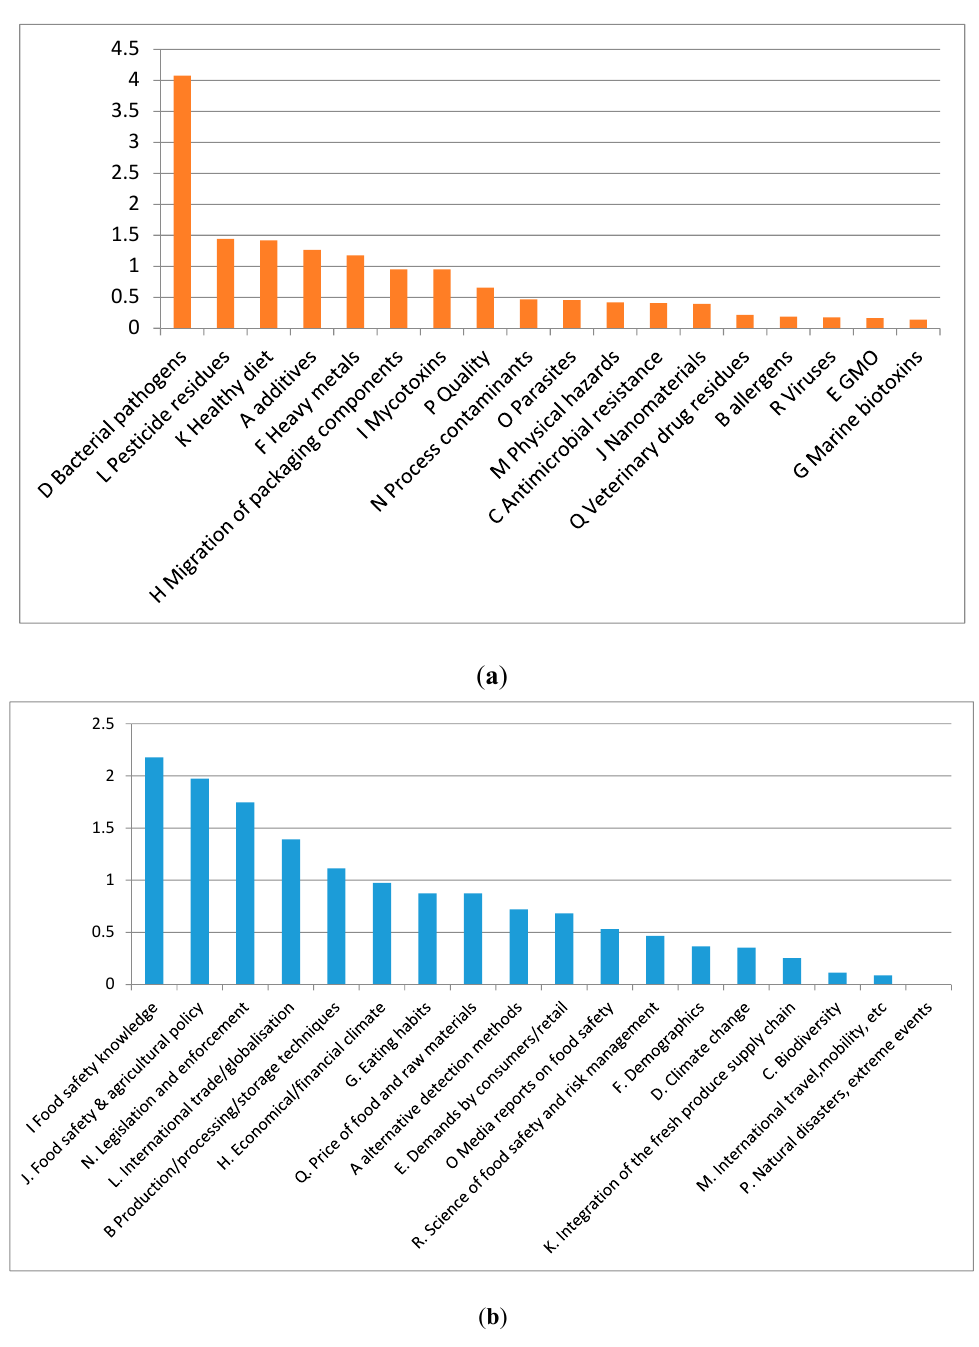
Figure 1. ( a ) main food safety issues of concern and ( b ) main contextual factors perceived to impact food safety (consultation of ITP Food safety Trainees at Ghent University, 2011–2015, n = 79